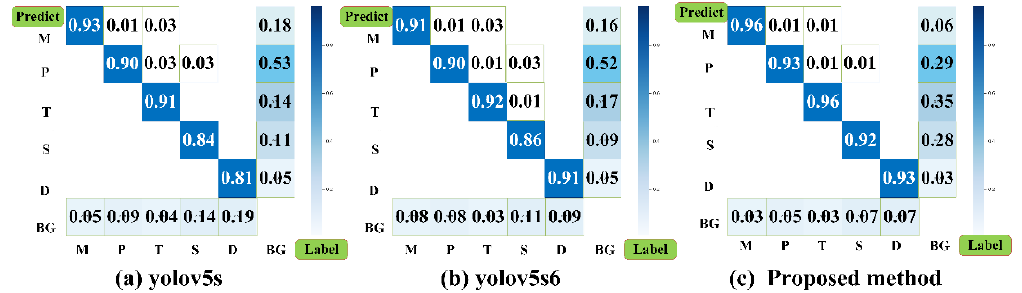
Figure 18. Confusion matrix results for detection. ( a ) Confusion matrix of detection results for yolov5s. ( b ) Confusion matrix of detection results for yolov5s6. ( c ) Confusion matrix of detection results for our proposed method.